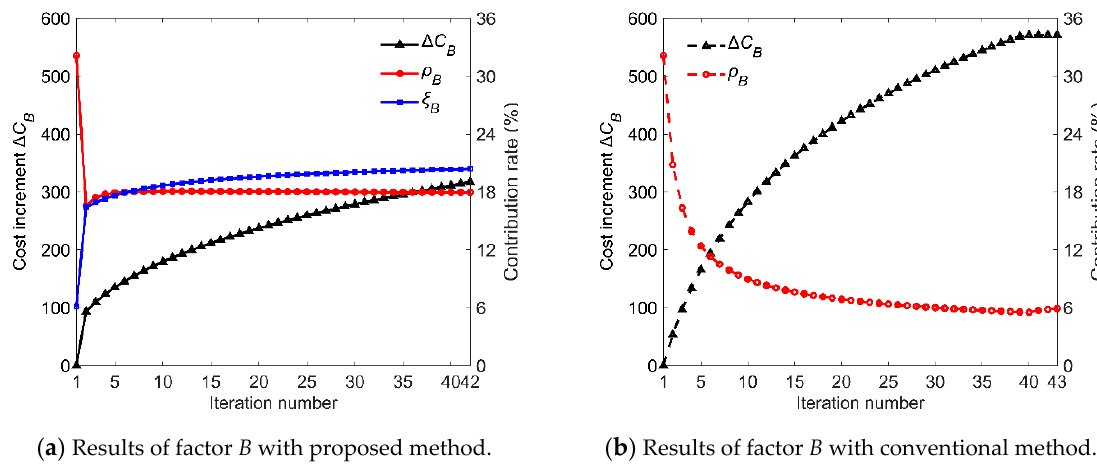
Figure 12. Results of factor B with proposed and conventional method.